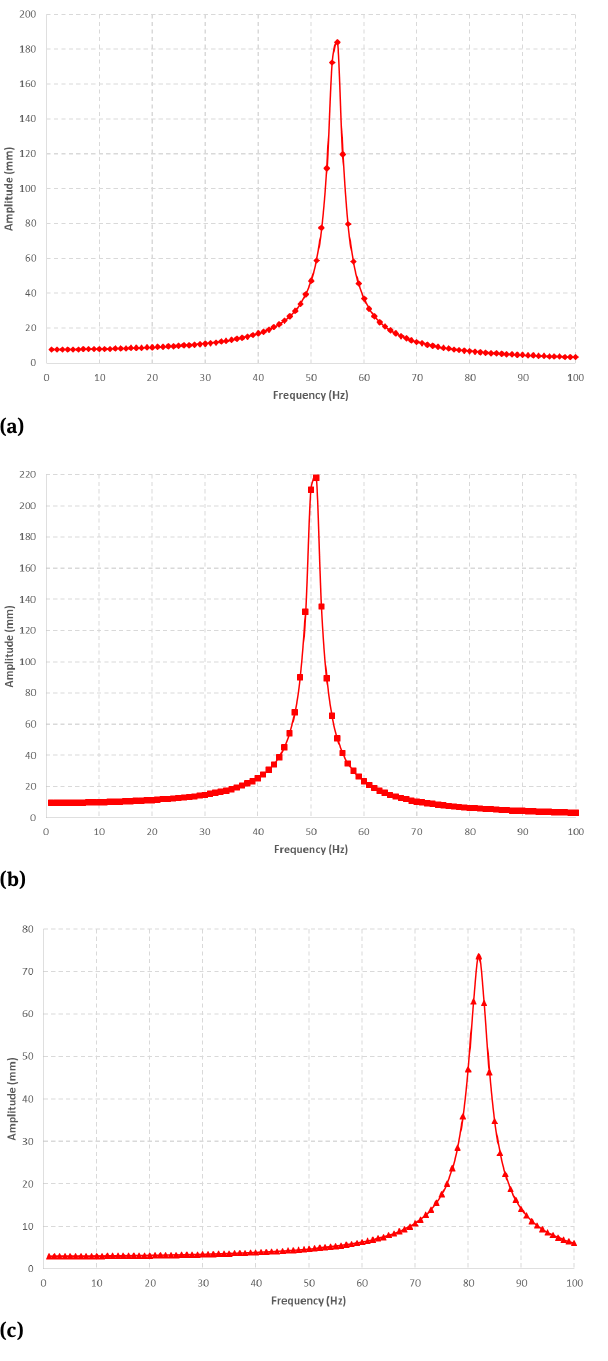
Figure 5: Frequency vs. amplitude of low-carbon steel materials: ( a ) virgin metal sheet; ( b ) hole metal sheet; ( c ) stiffener metal sheet